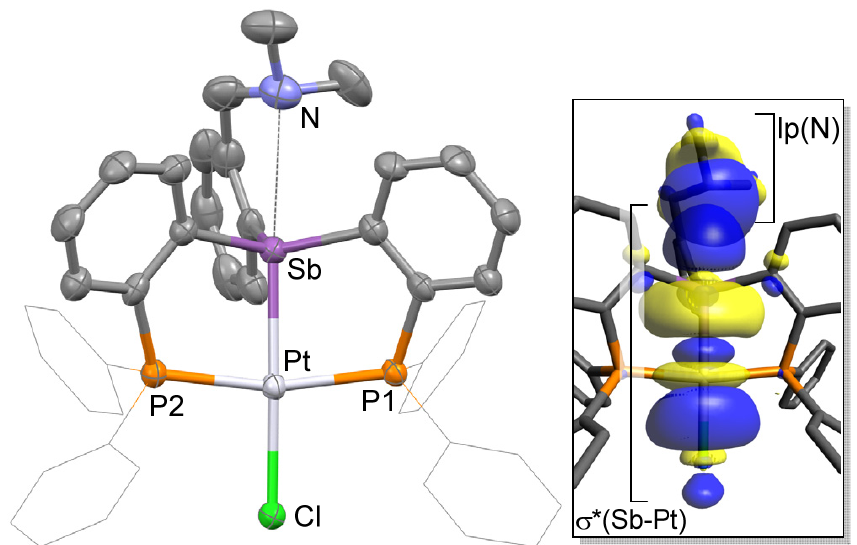
Figure 2. Solid-state structure of complex [3][Cl]. Thermal ellipsoids are drawn at the 50% probability level. The hydrogen atoms, interstitial solvent molecules, and counteranions are omitted for clarity while the Ph groups are draw as thin lines. Relevant metrical parameters can be found in the text. This distance is longer than that measured in E [30] or F [26], which possess N → Sb dative interactions of 2.693(11) Å and 2.463(2) Å, respectively (Figure 3). Based on this comparison, we conclude that an N → Sb dative interaction is also present in [ 3 ][Cl], even if weaker than in E and F . Efforts to reproduce the experimental geometry with DFT methods were not successful and led to computed structures where the Sb–N distance was overestimated by ~0.3 Å. We assign our difficulty in reproducing this distance to its inherent weakness. An optimization carried out with the MPW1PW91 functional, a mixed basis set, and application of a solvation model afforded a N–Sb distance of 3.26 Å. Despite this elongation, an NBO analysis of the bonding indicates the persistence of an N → Sb dative interaction that accounts for E del = 8.0 kcal/mol to the stability of the molecule (Figure 2, Figure S11).